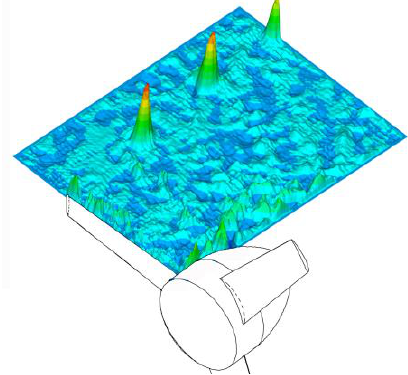
Fig. 6 Absolute value of circulation distribution.